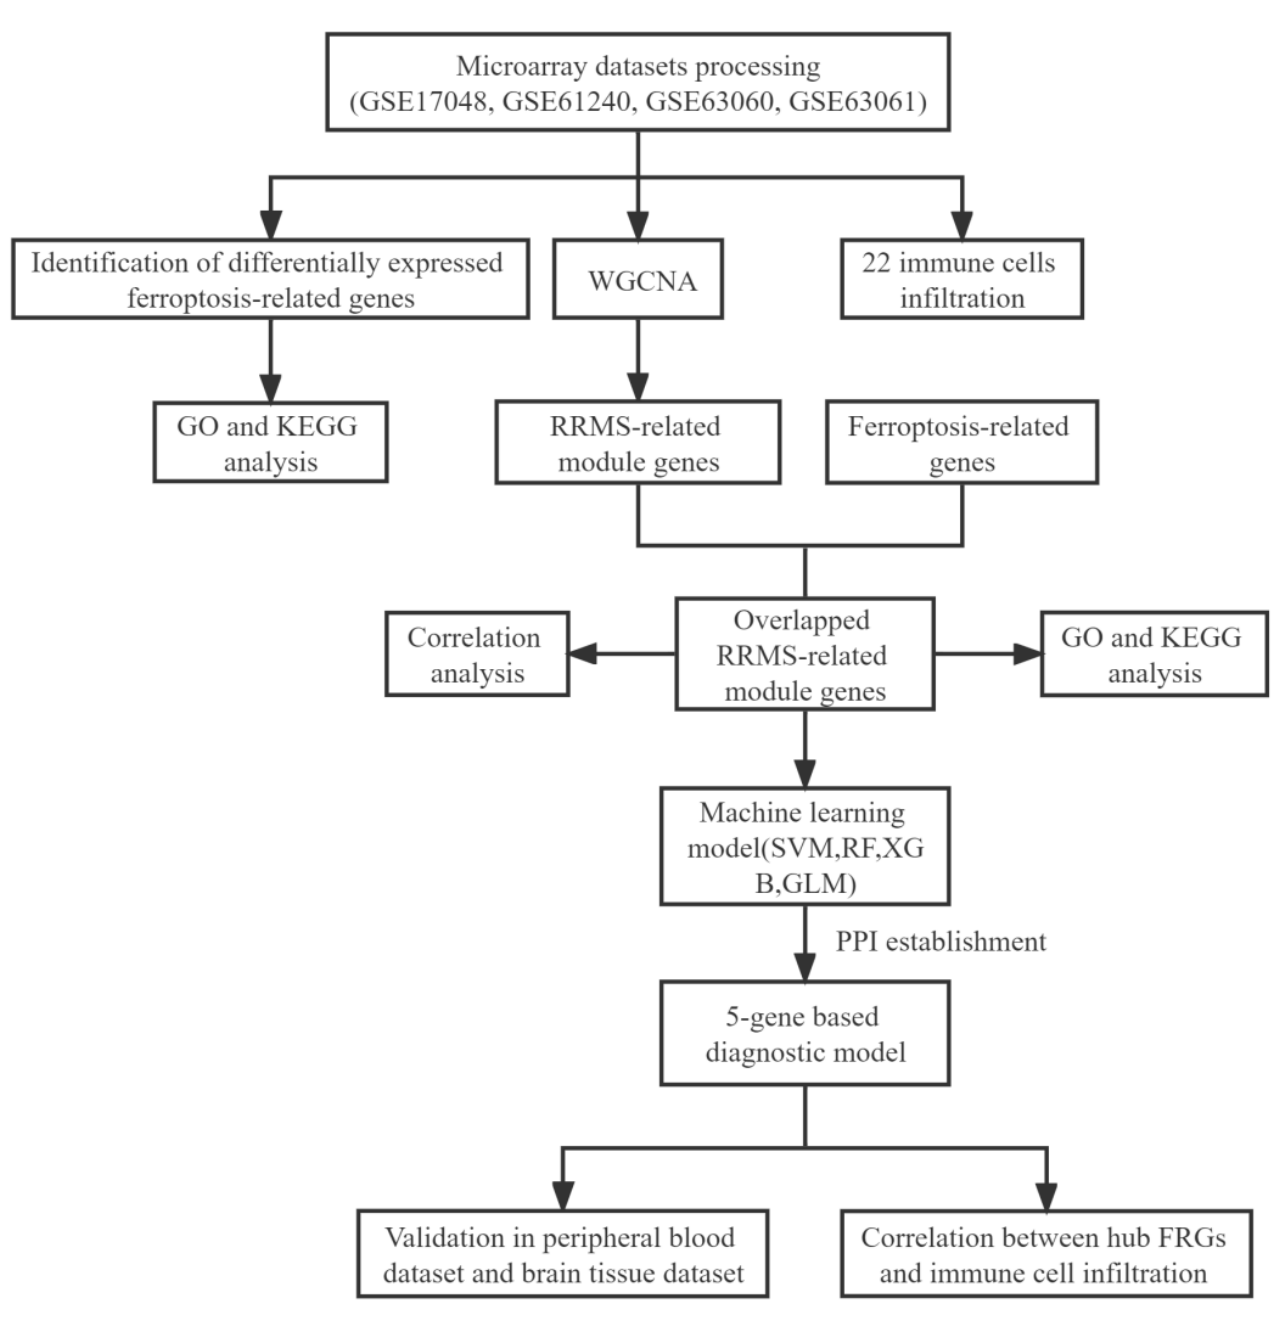
Figure 1. The workflow chart of the whole analysis process in this study. WGCNA, weighted gene co-expression network analysis; RRMS, relapsing-remiting multiple sclerosis; GO, Gene Ontology; KEGG, Kyoto Encyclopedia of Genes and Genomes; SVM, support vector machine model; RF, random forest model; XGB, extreme gradient boosting model; GLM, generalized linear model; FRGs, ferroptosis-related genes.